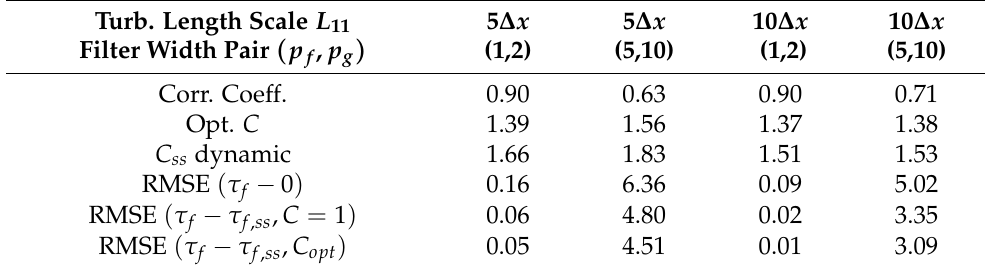
Figure 3. ( a ) (Filtered) gradients of the data (filtered data) shown in Figure 2. ( b ) Commutation error given by ∂ u / ∂ x − ∂ u / ∂ x together with scale similarity model for the commutation error, given by Equation (25) using C = 1. Table 1. Performance of model τ f , ss for different initial data and different filter sizes (note that the correlation coefficient is independent of the secondary filter). Dynamically determined model coefficient C and mean squared error between commutation error and different approximations, for different initial data and different f , g filter size pairs ( p f , p g )